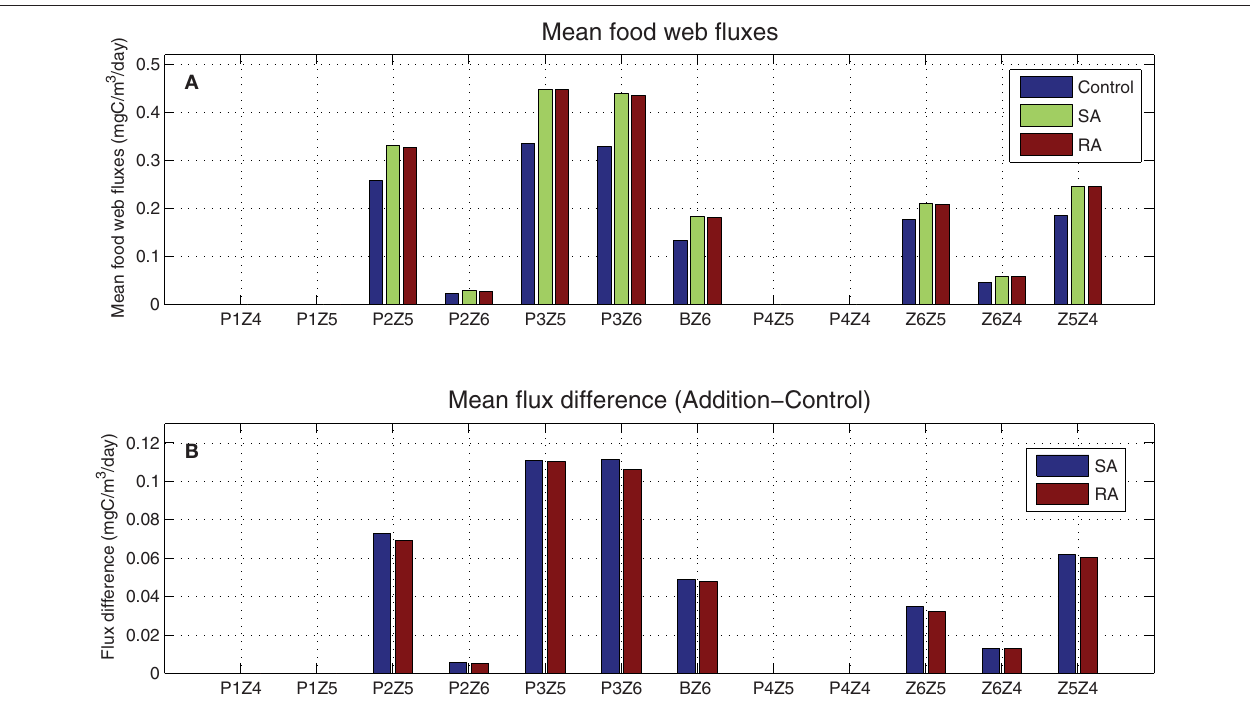
FIGURE 6 | (A) Simulated mean food web carbon fluxes for addition (SA/RA) and control treatments (mgC/m 3 /day) and (B) their difference (SA/RA-Control). P1, diatoms; P2, nanophytoplankton; P3, picophytoplankton; P4, dinoflagellates; B, bacteria; Z6, HNAN; Z5, microzooplankton; Z4, mesozooplankton (see Figure 1 ).